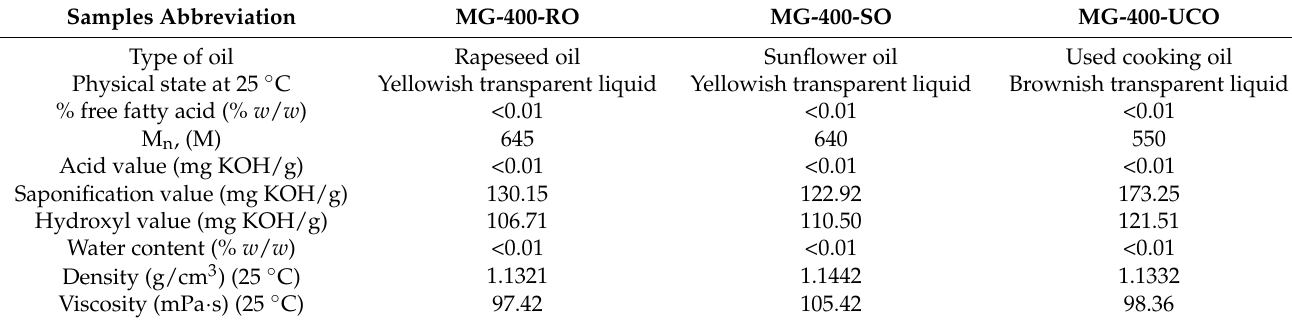
Table 2. Physical properties of plant Oil PEG-8 ester solvents.